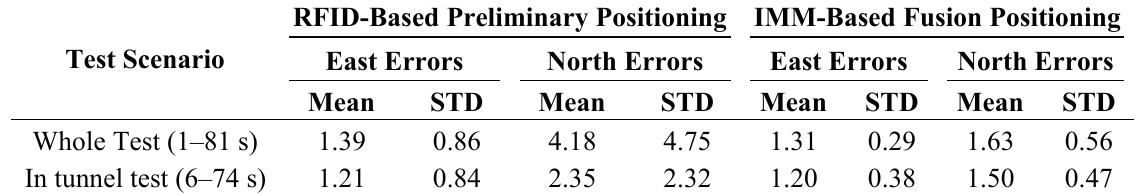
Table 3. The mean and standard deviation of east and north positioning error (unit: m).